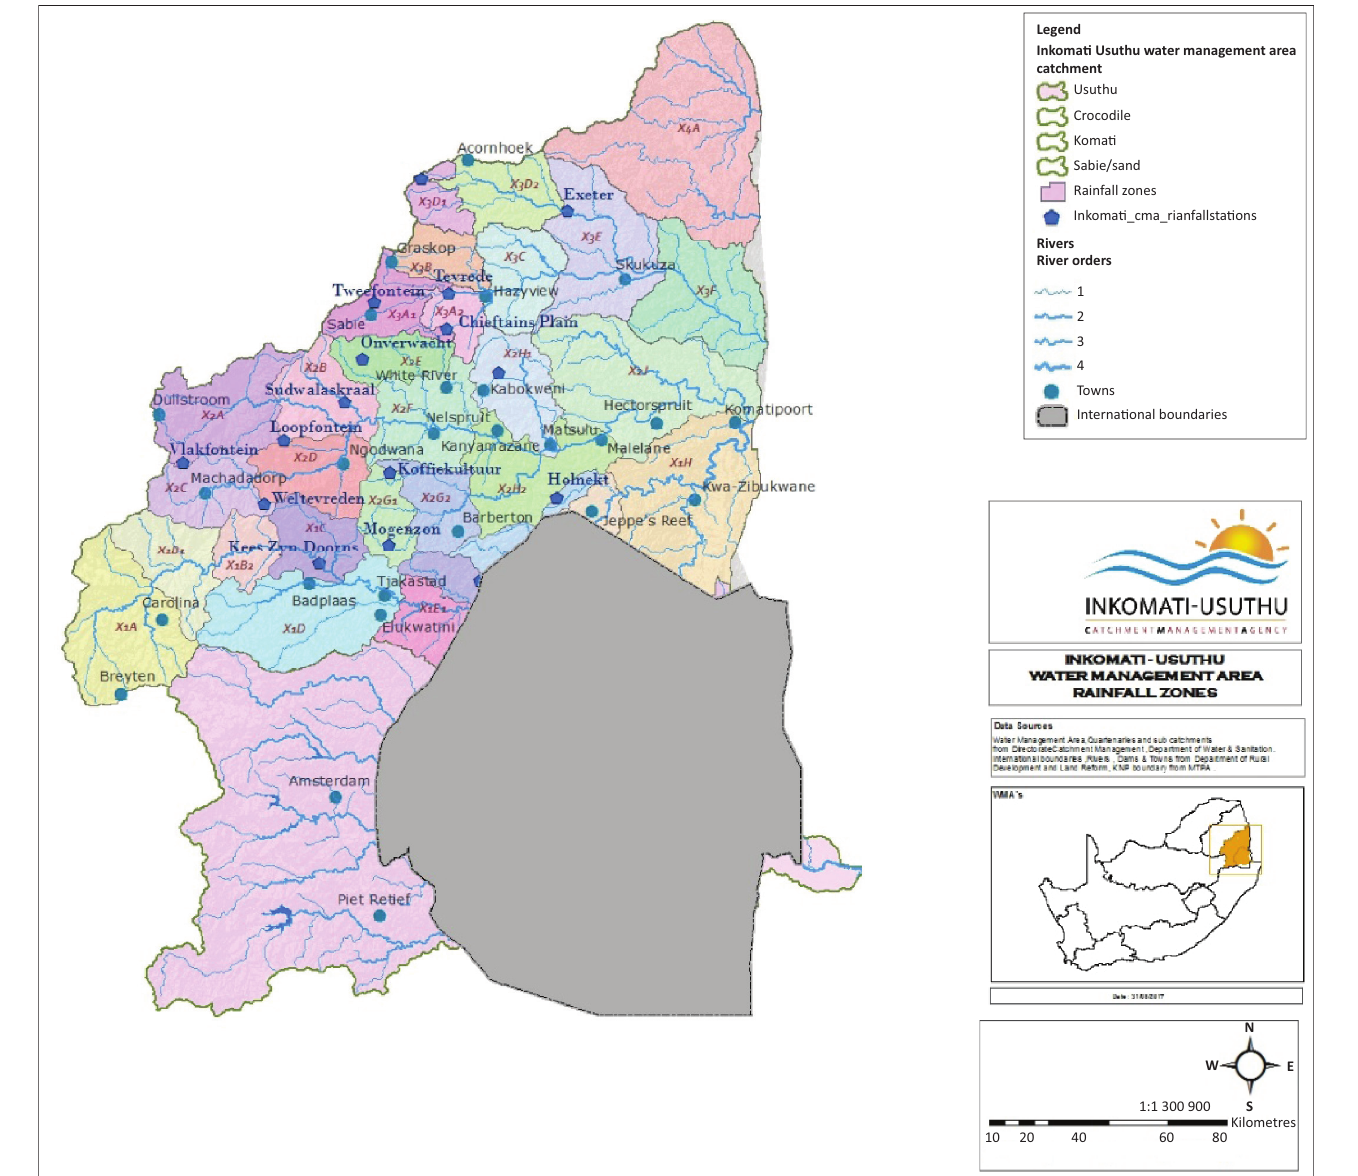
FIGURE 1: Map showing the Inkomati-Usuthu catchment management area rainfall